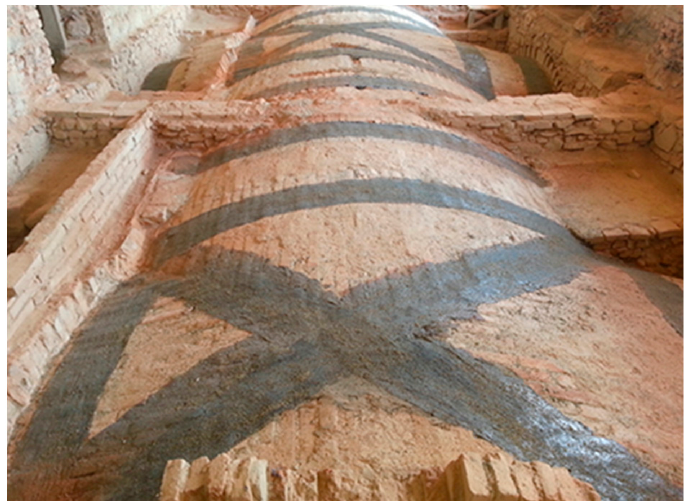
Figure 14. Vaults strengthening at the extrados [64].